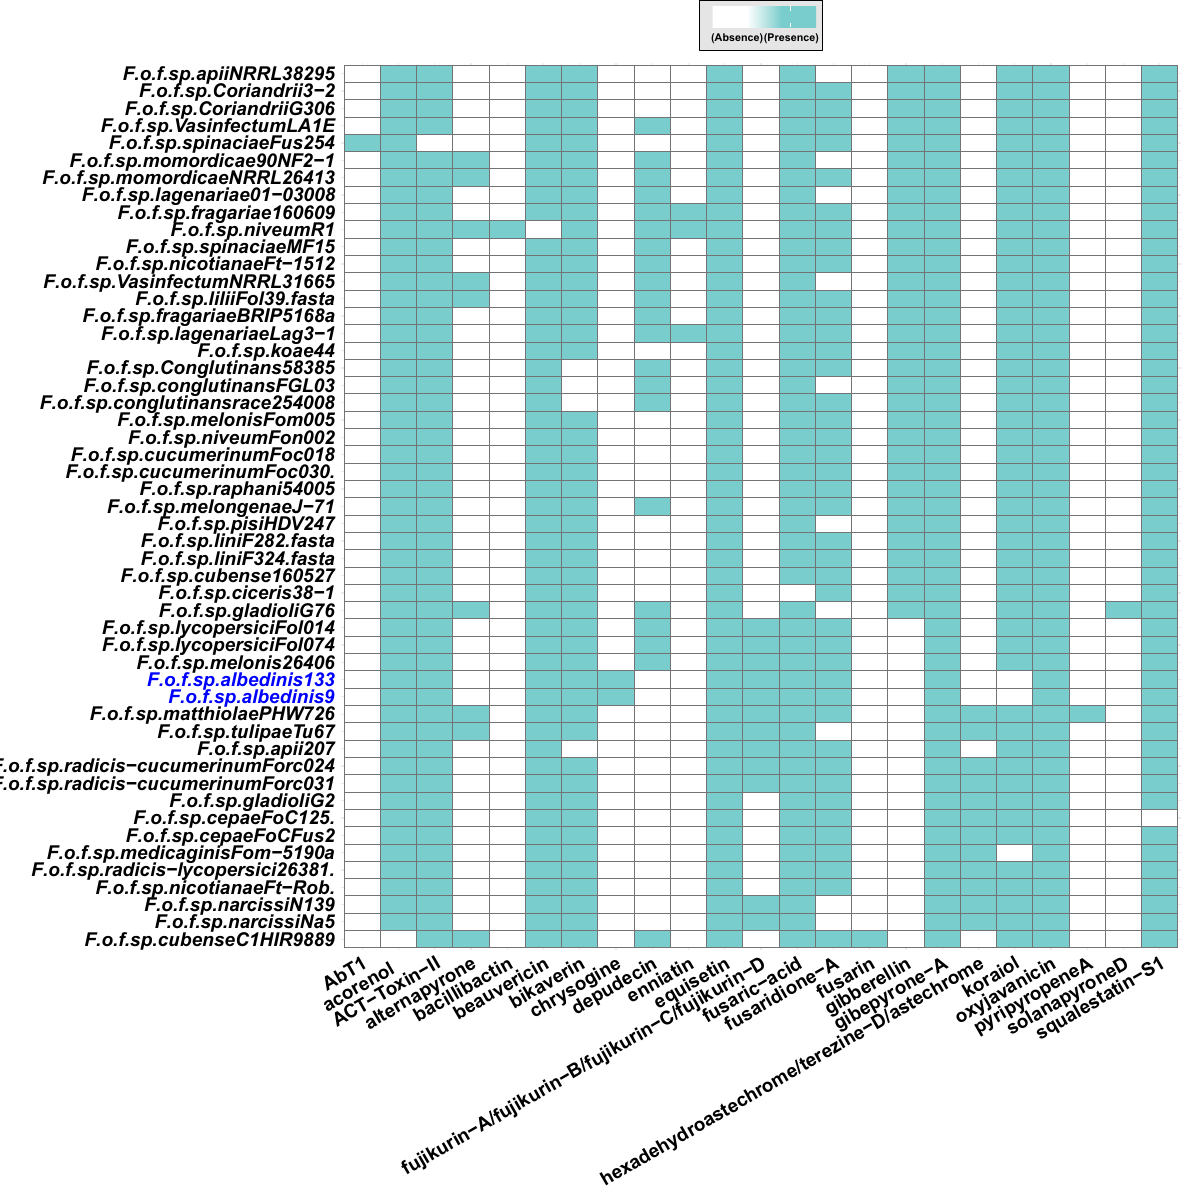
F.o.f.sp.pisiHDV247F.o.f.sp.melongenaeJ−71F.o.f.sp.raphani54005F.o.f.sp.cucumerinumFoc030.F.o.f.sp.cucumerinumFoc018F.o.f.sp.niveumFon002F.o.f.sp.melonisFom005F.o.f.sp.conglutinansrace254008F.o.f.sp.conglutinansFGL03F.o.f.sp.Conglutinans58385F.o.f.sp.koae44F.o.f.sp.lagenariaeLag3−1F.o.f.sp.fragariaeBRIP5168aF.o.f.sp.liliiFol39.fastaF.o.f.sp.VasinfectumNRRL31665F.o.f.sp.nicotianaeFt−1512F.o.f.sp.spinaciaeMF15F.o.f.sp.niveumR1F.o.f.sp.fragariae160609F.o.f.sp.lagenariae01−03008F.o.f.sp.momordicaeNRRL26413F.o.f.sp.momordicae90NF2−1F.o.f.sp.spinaciaeFus254F.o.f.sp.VasinfectumLA1EF.o.f.sp.CoriandriiG306F.o.f.sp.Coriandrii3−2F.o.f.sp.apiiNRRL38295 F.o.f.sp.cubenseC1HIR9889F.o.f.sp.narcissiNa5F.o.f.sp.narcissiN139F.o.f.sp.nicotianaeFt−Rob.F.o.f.sp.radicis−lycopersici26381.F.o.f.sp.medicaginisFom−5190aF.o.f.sp.cepaeFoCFus2F.o.f.sp.cepaeFoC125.F.o.f.sp.gladioliG2F.o.f.sp.radicis−cucumerinumForc031F.o.f.sp.radicis−cucumerinumForc024F.o.f.sp.apii207F.o.f.sp.tulipaeTu67F.o.f.sp.matthiolaePHW726F.o.f.sp.albedinis9F.o.f.sp.albedinis133F.o.f.sp.melonis26406F.o.f.sp.lycopersiciFol074F.o.f.sp.lycopersiciFol014F.o.f.sp.gladioliG76F.o.f.sp.ciceris38−1F.o.f.sp.cubense160527F.o.f.sp.liniF324.fastaF.o.f.sp.liniF282.fasta Figure 9. Predicted secondary metabolite families in the analyzed formae speciales . presence/absence map of secondary metabolite families detected in the genomes of the Foa and the other formae speciales . Blue boxes indicate the presence of secondary metabolite families and empty boxes indicate their absence in each strain. Abbreviations: F (Fusarium); o (oxysporum); f (forma); sp (specialis) . The names following the abbreviations represent the names of the formae speciales ; the abbreviations coming after the names of the formae speciales correspond to the strains belonging to these formae speciales (F.o.f.sp. albedinis 133: Fusarium osysporum forma specialis albedinis Foa